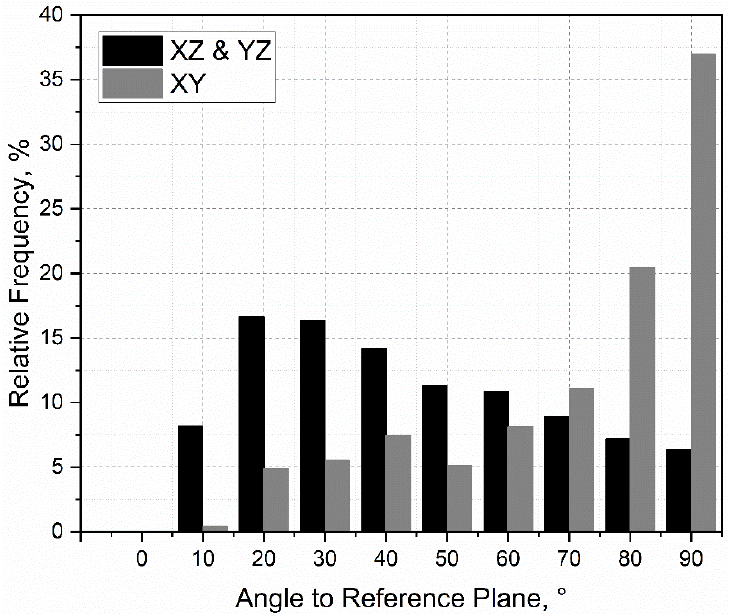
Figure 14. Orientation of the grains relative to the referential plane.